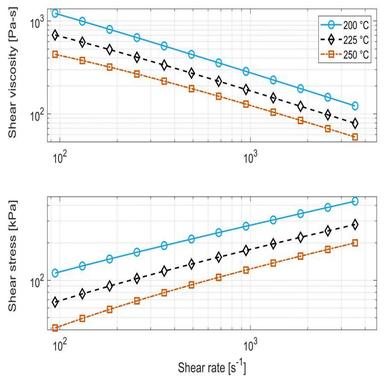
Log-Log plots of shear viscosity (top) and shear stress (bottom) as a function of shear rate for the ABS filament used in this study. The temperatures and shear rates used are reflective of experimental conditions and are representative of the temperatures and shear rates observed in the material extrusion printer.